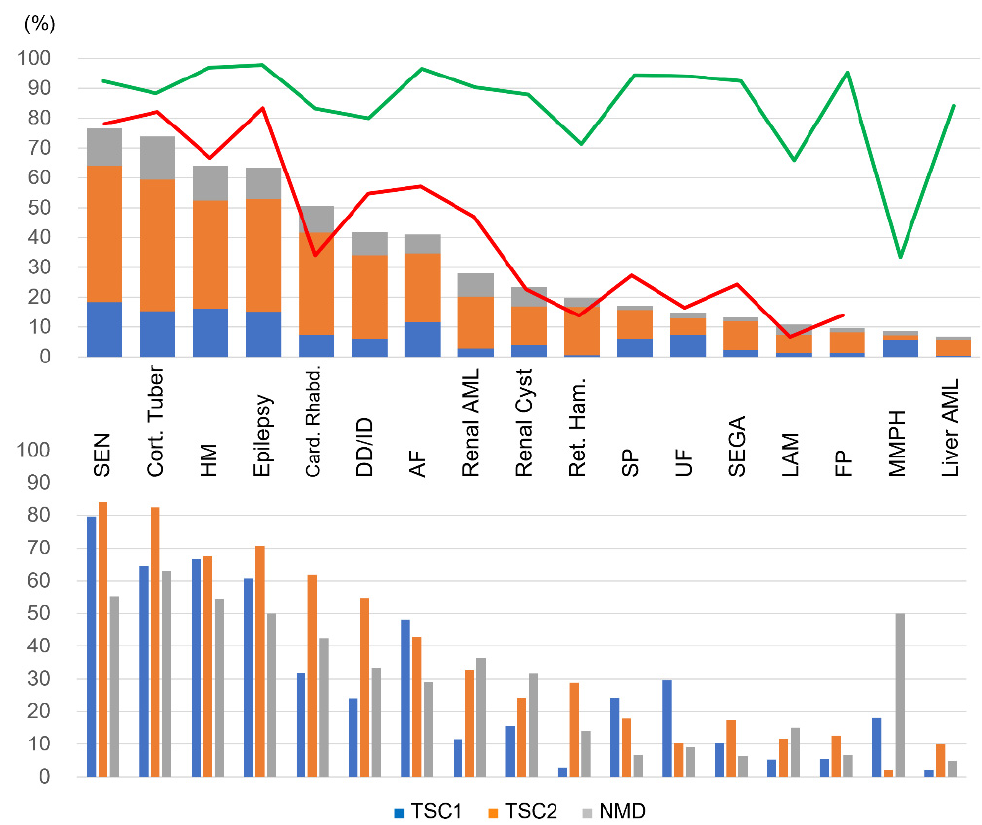
Figure 2. Frequency of each lesion and symptom. ( upper panel ) Frequency of each lesion among all definite TSC patients. The proportion of TSC1, TSC2, and no mutation detected (NMD) for each symptom is shown. The green line indicates the testing rates for each condition. The red line indi- cates the frequency in the TOSCA baseline study. ( lower panel ) Percentage of each symptom by TSC1, TSC2, and NMD patients are presented. AF: facial angiofibroma; AML: angiomyolipoma; Card. Rhabd.: cardiac rhabdomyoma; Cort.Tuber: cortical tubers; DD/ID: developmental delay/in- tellectual disability; FP: forehead plaque; HM: hypomelanotic macules; LAM: lymphangiomyoma- tosis; MMPH: multifocal micronodular pneumocyte hyperplasia; Ret. Ham.: retinal hamartoma; SEGA: subependymal giant cell astrocytoma; SEN: subependymal nodules; SP: shagreen patch; UF: ungual fibroma.